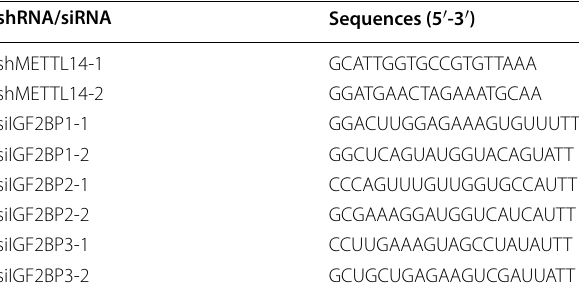
Table 1 shRNA and siRNA sequences used in this study